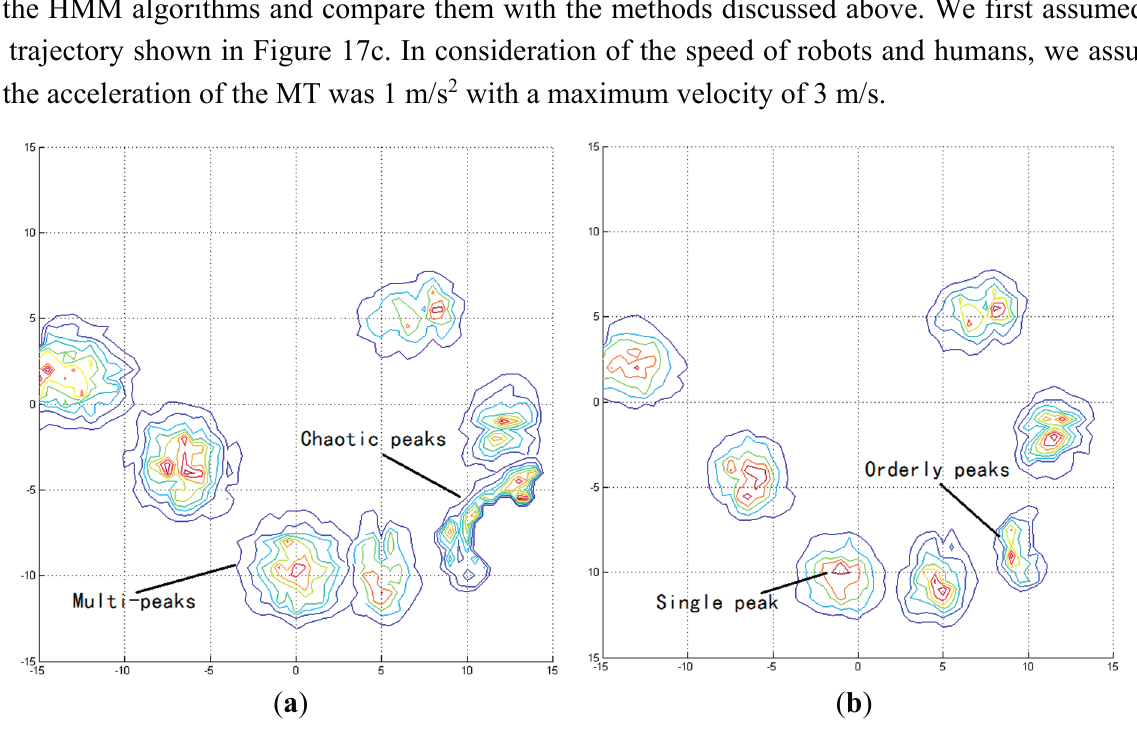
Figure 16. Analysis of five dispersion points based on P ( y i │ m i